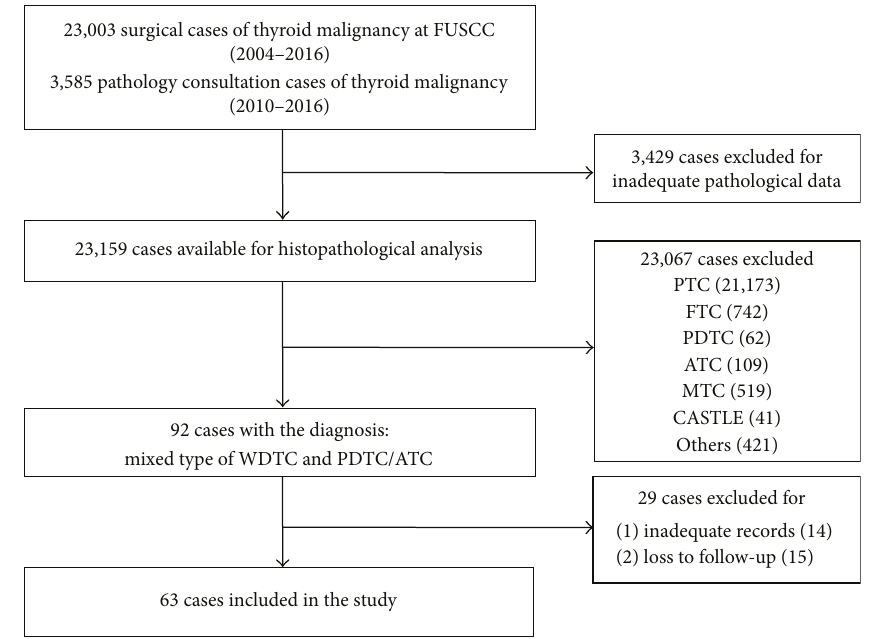
Figure 1: The fl ow graph of inclusion of WDTC patients harboring dedi ff erentiated phenotype in our